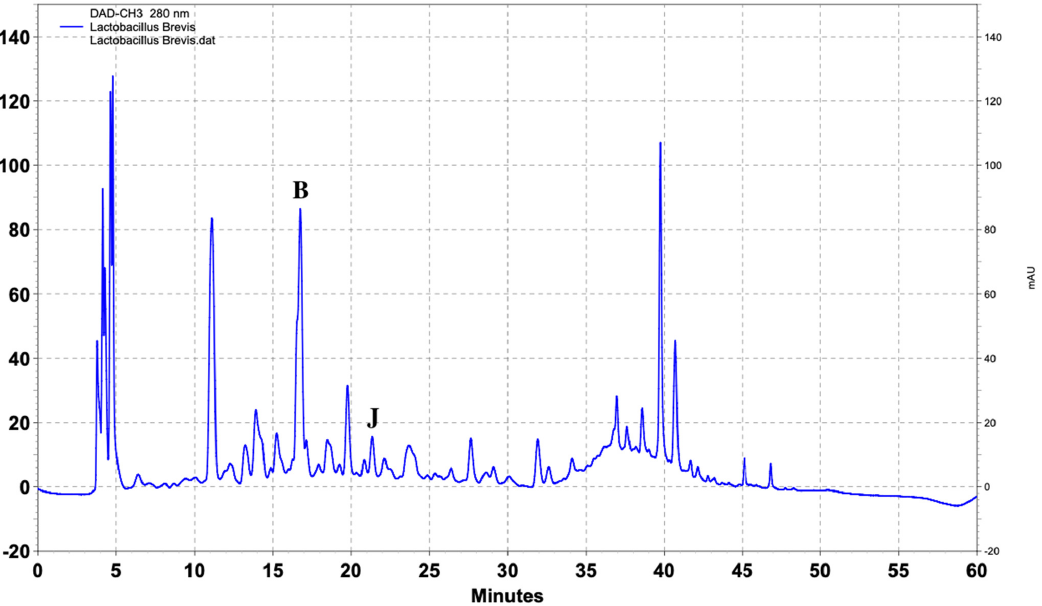
Figure 3. Chromatographic profile of Levilactobacillus brevis ATCC8287 showing antimicrobial activity. High mass accuracy spectrum of compound (B) OH-PLA (16.3 min); high mass accuracy spectrum of compound (J) Vanillic acid (21.3 min).